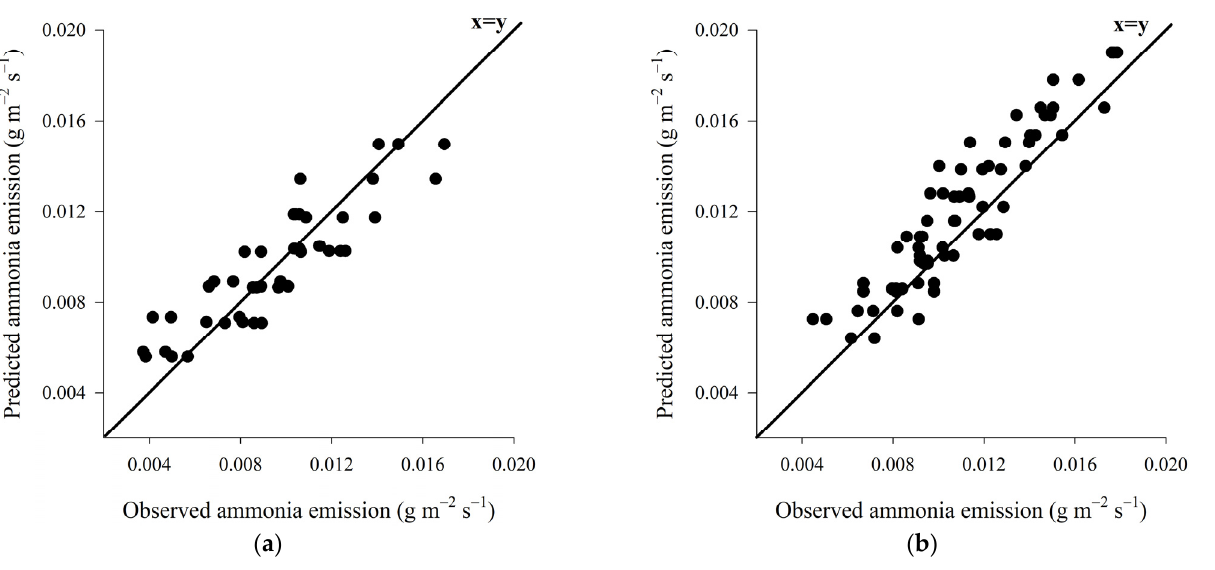
Figure 10. Representation of the ammonia emission prediction models for wood shaving bed ( a ) and coffee husk bed ( b ). coffee husk bed ( b